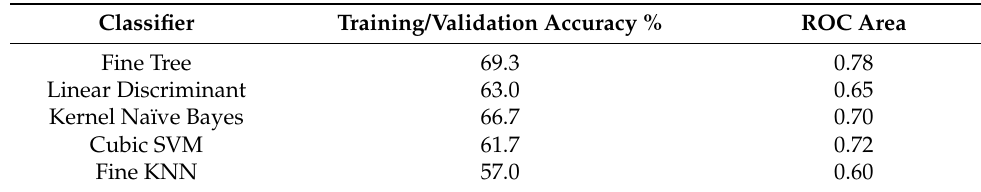
Table 4. Classification performance of the various algorithms using handcrafted statistical features from experimental data.